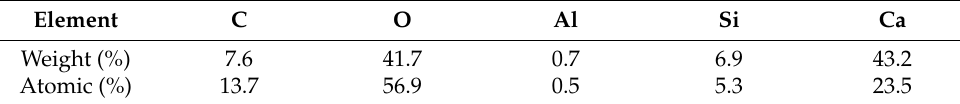
Figure 6. EDS element content analysis in recycled fines shown in Figure 5b. Table 4. The results of the elemental composition analysis of recycled fines.